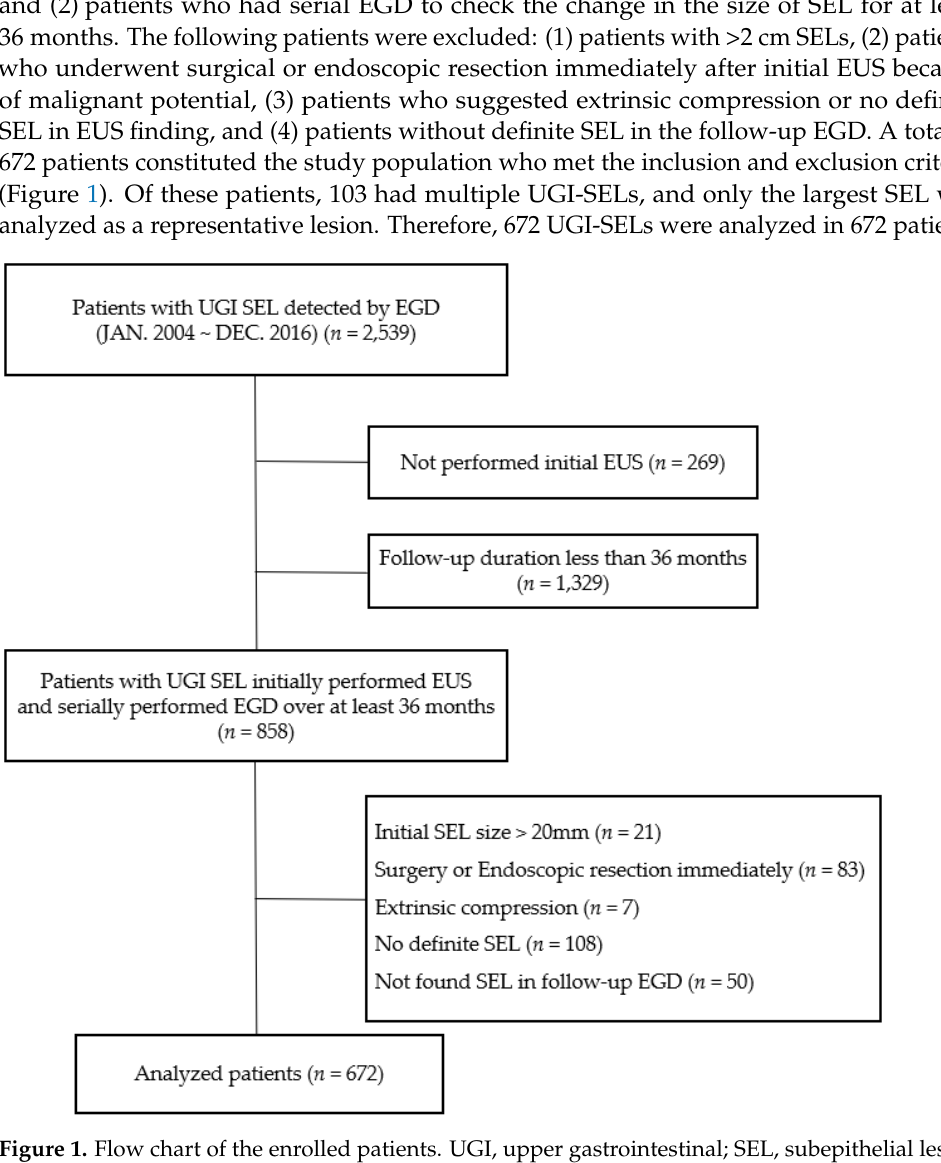
Figure 1. Flow chart of the enrolled patients. UGI, upper gastrointestinal; SEL, subepithelial lesion; EGD, esophagogastroduodenoscopy; EUS, endoscopic ultrasonography.